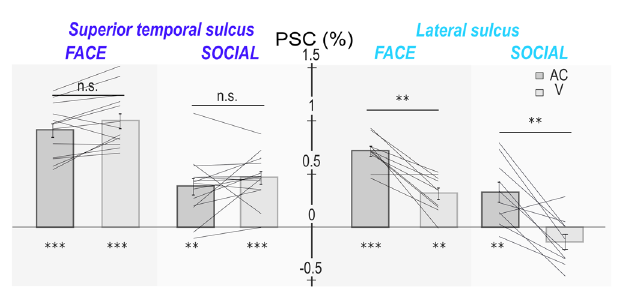
Fig. 8 | Percentage of signal change (PSC) across all lateral sulcus (light blue) and superior temporal sulci (dark blue) ROIs ofboth hemispheres, comparing the auditory and visual contexts (median±s.e., single lines correspond to the PSC computed over single ROIs from the group analysis; n =14 ROIs for STS and n =10 ROIs for LS). Statistical differences relative to fi xation are between contextsandindicatedasfollows:***, p <0.001;**,p<0.01;n.s., p >0.05(Wilcoxon two-sided non-parametric test). STS: FACE: AC: n =560, Z =16.14, p =4.1e-57; V: n =560, Z =19.35, p =1.8e-68; AC vs V: Z =1.68, p =0.09. SOCIAL: AC: n =1106, Z =11.49, p =0.0011; V: n =1106, Z =14.87, p =1.5e-49; ACvs V: Z =2.4, p =0.051.